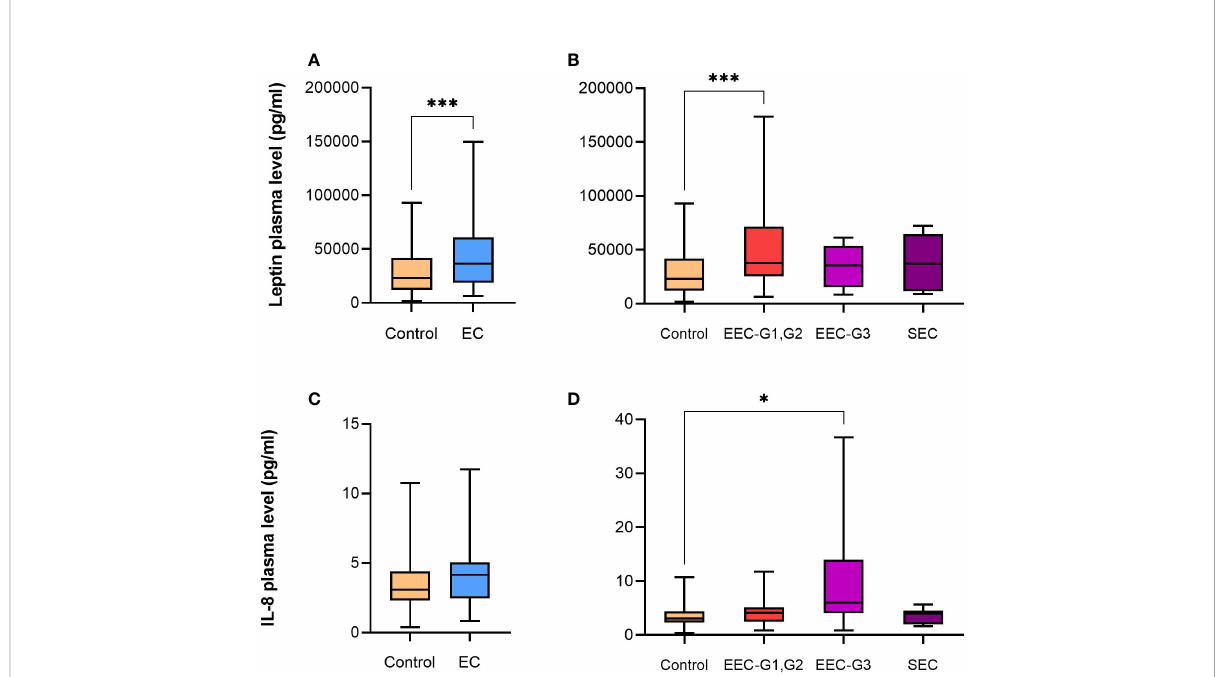
FIGURE 1 Box plots with median, minimum and maximum for plasma leptin and IL-8 levels (pg/mL). (A, C) Control patients and patients with endometrial cancer. (B, D) Control patients and patients with histological subtypes of endometrial cancer – Type I (EEC G1, G2) and Type II (EEC G3 and SEC). EC – endometrial cancer, EEC – endometrioid endometrial cancer, SEC – serous endometrial cancer, G – grade. Adjusted p values: *p < 0.05, ***p <